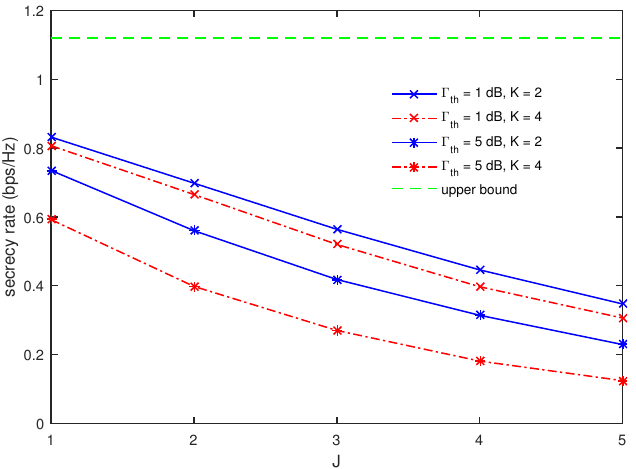
Figure 6. Comparison of multicast secrecy rate as a function of J for different values of Γ th and K when M = 4, I = 4, and d R = 50